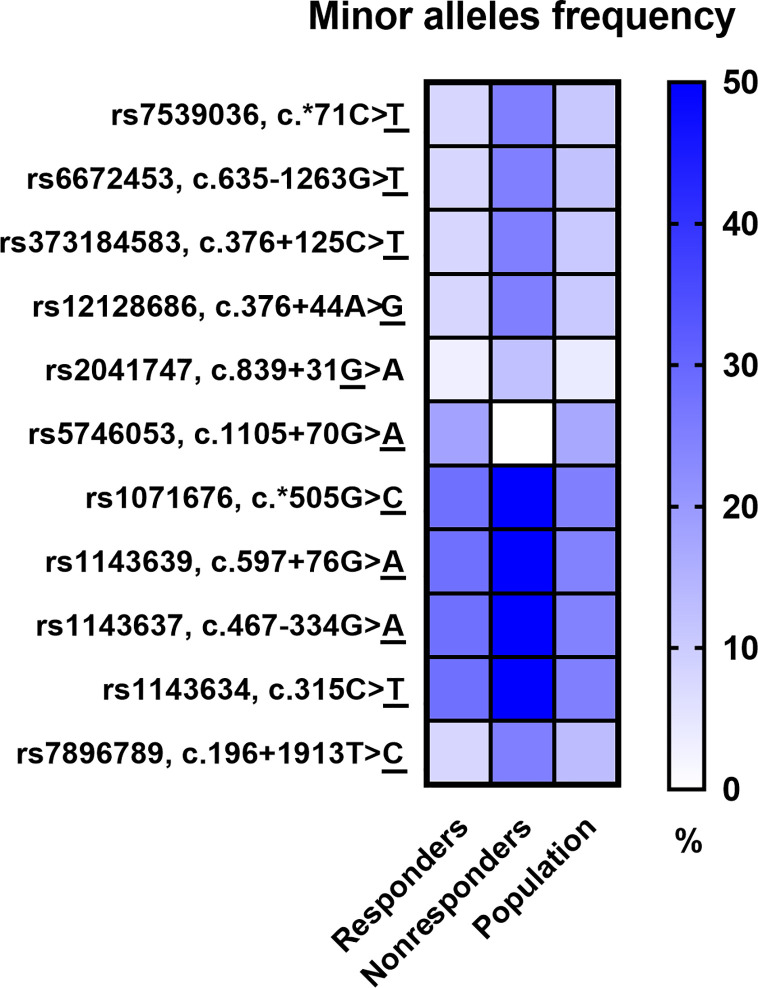
Comparison of minor alleles frequency (MAF) in the study groups and the European population.